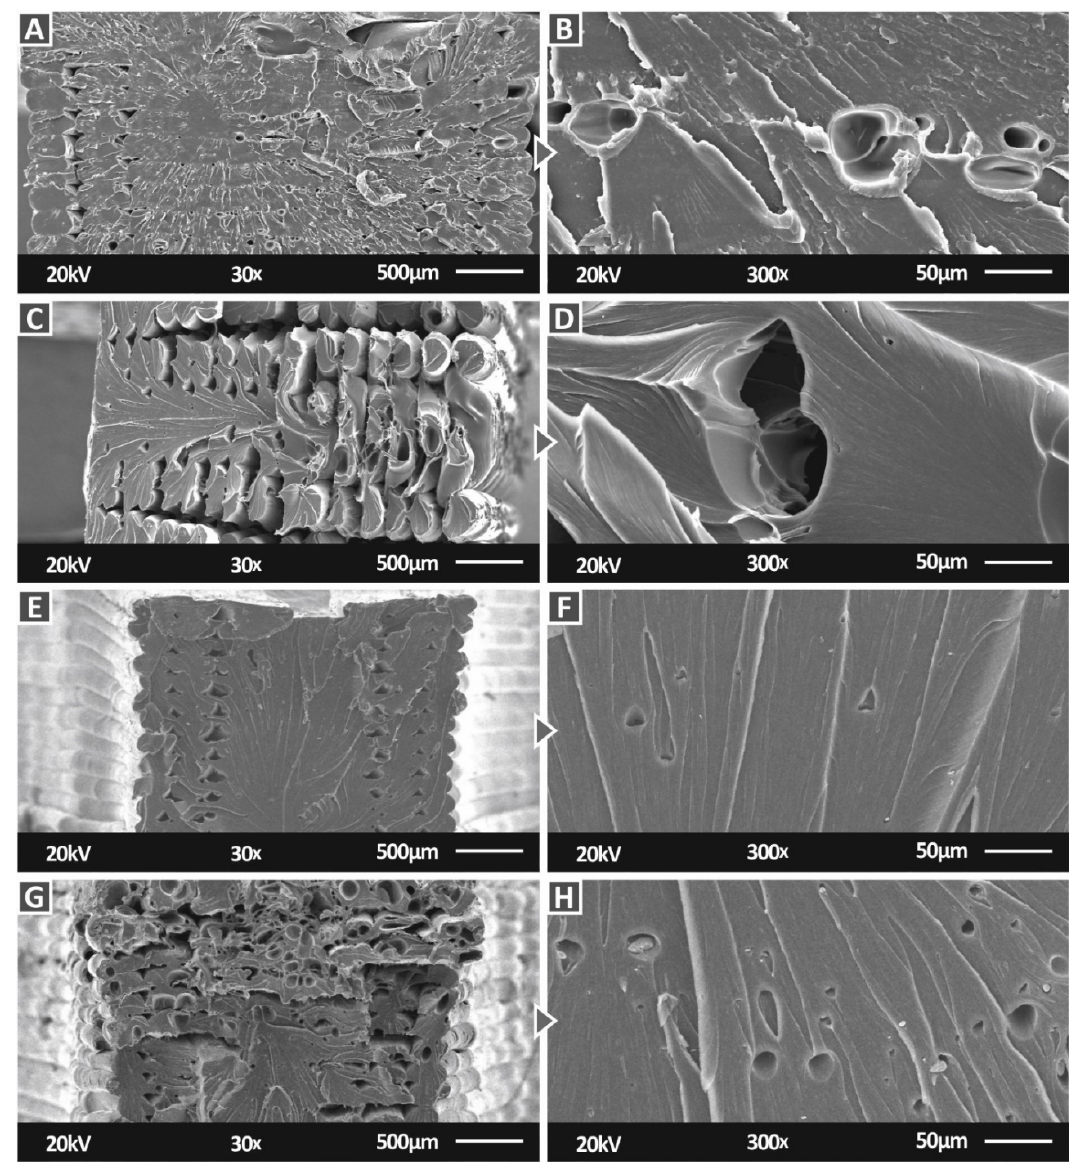
Figure 15. SEM images of the PC/TiC nanocomposites fracture surface: ( A ) 1 wt.% at 30×, ( B ) 1 wt.% at 300×, ( C ) 2 wt.% at 30×, ( D ) 2 wt.% at 300×, ( E ) 3 wt.% at 30×, ( F ) 3 wt.% at 300×, ( G ) 6 wt.% at 30×, and ( H ) 1 wt.% at 300×.